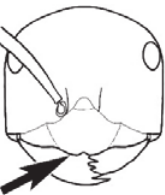
– In full-face view, anteromedial margin of clypeus not produced as a narrow, rectangular flange ...................................................................................... 28